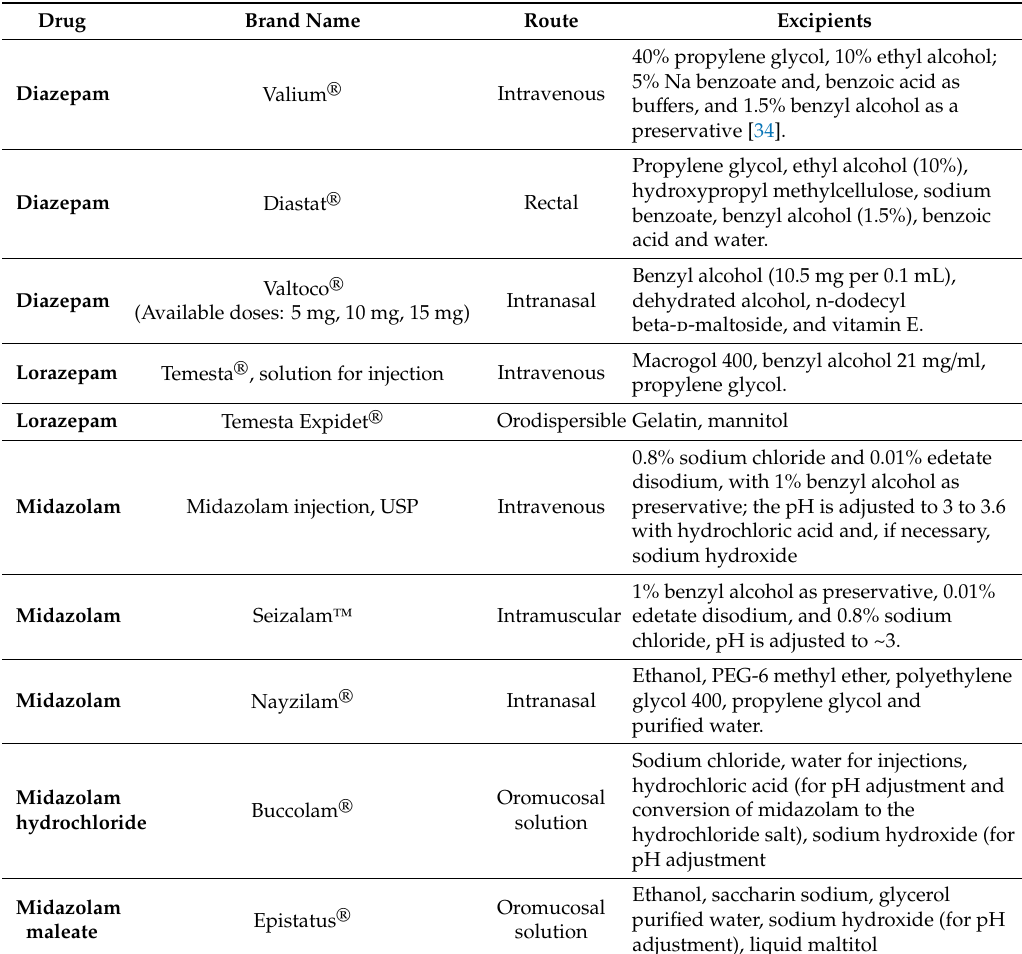
Table 3. List of marketed products for acute repetitive